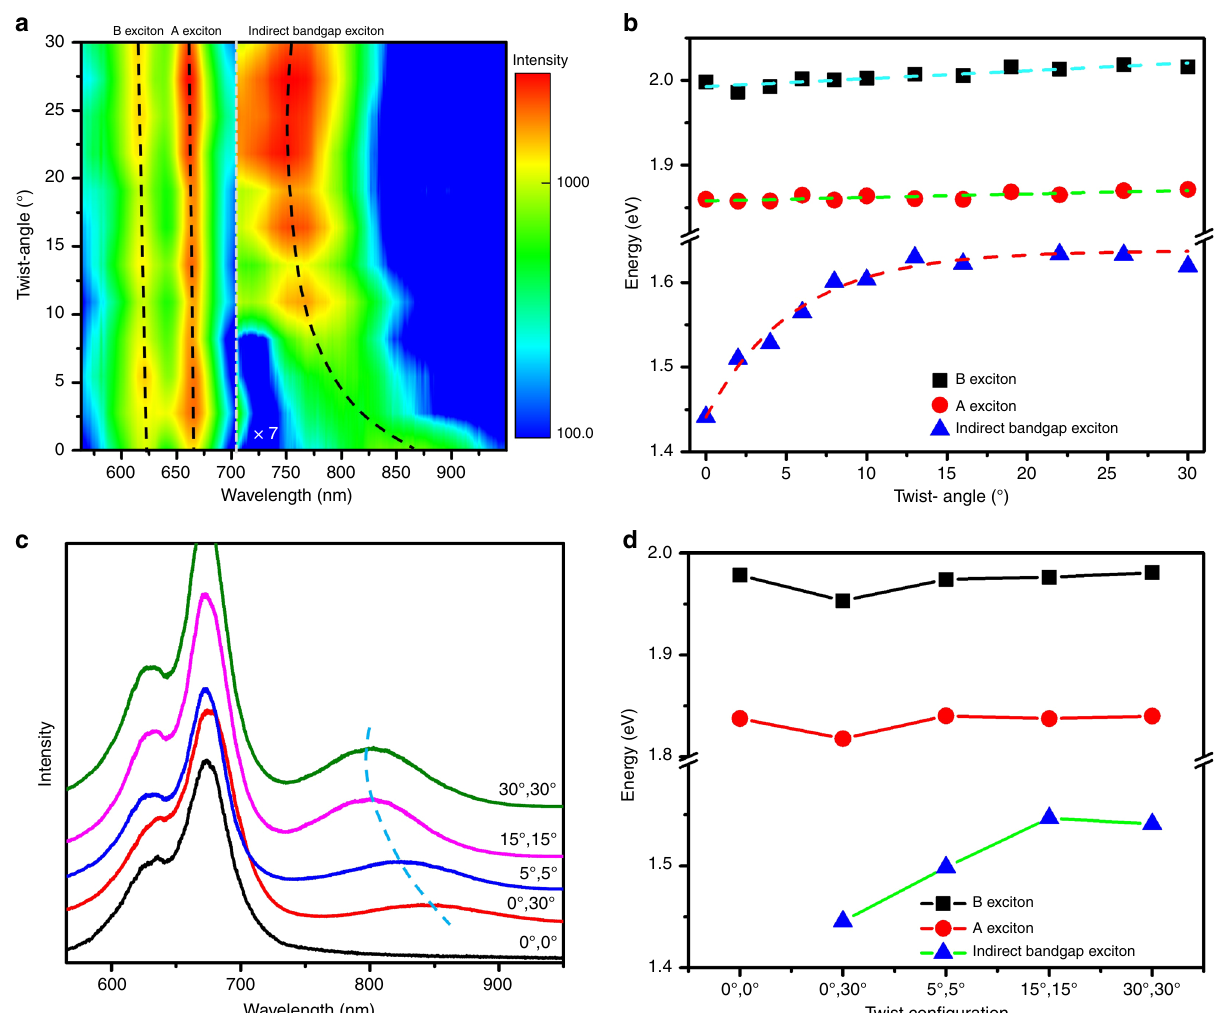
Fig. 3 PL spectra characterization of twisted multilayer MoS 2 fi lms. a PL spectra of twisted bilayer MoS 2 fi lms as a function of twist angle; the signal intensity between 706 nm to 950 nm is multiplied by 7. b Excitons ’ energy as a function of the twist angle; dash lines are linear (A and B excitons) and exponential (indirect bandgap exciton) fi tting. c PL spectra of twisted trilayer MoS 2 fi lms with various twist con fi gurations. d Excitons ’ energy as a function of twist con fi guration. Source data are provided as a Source Data fi